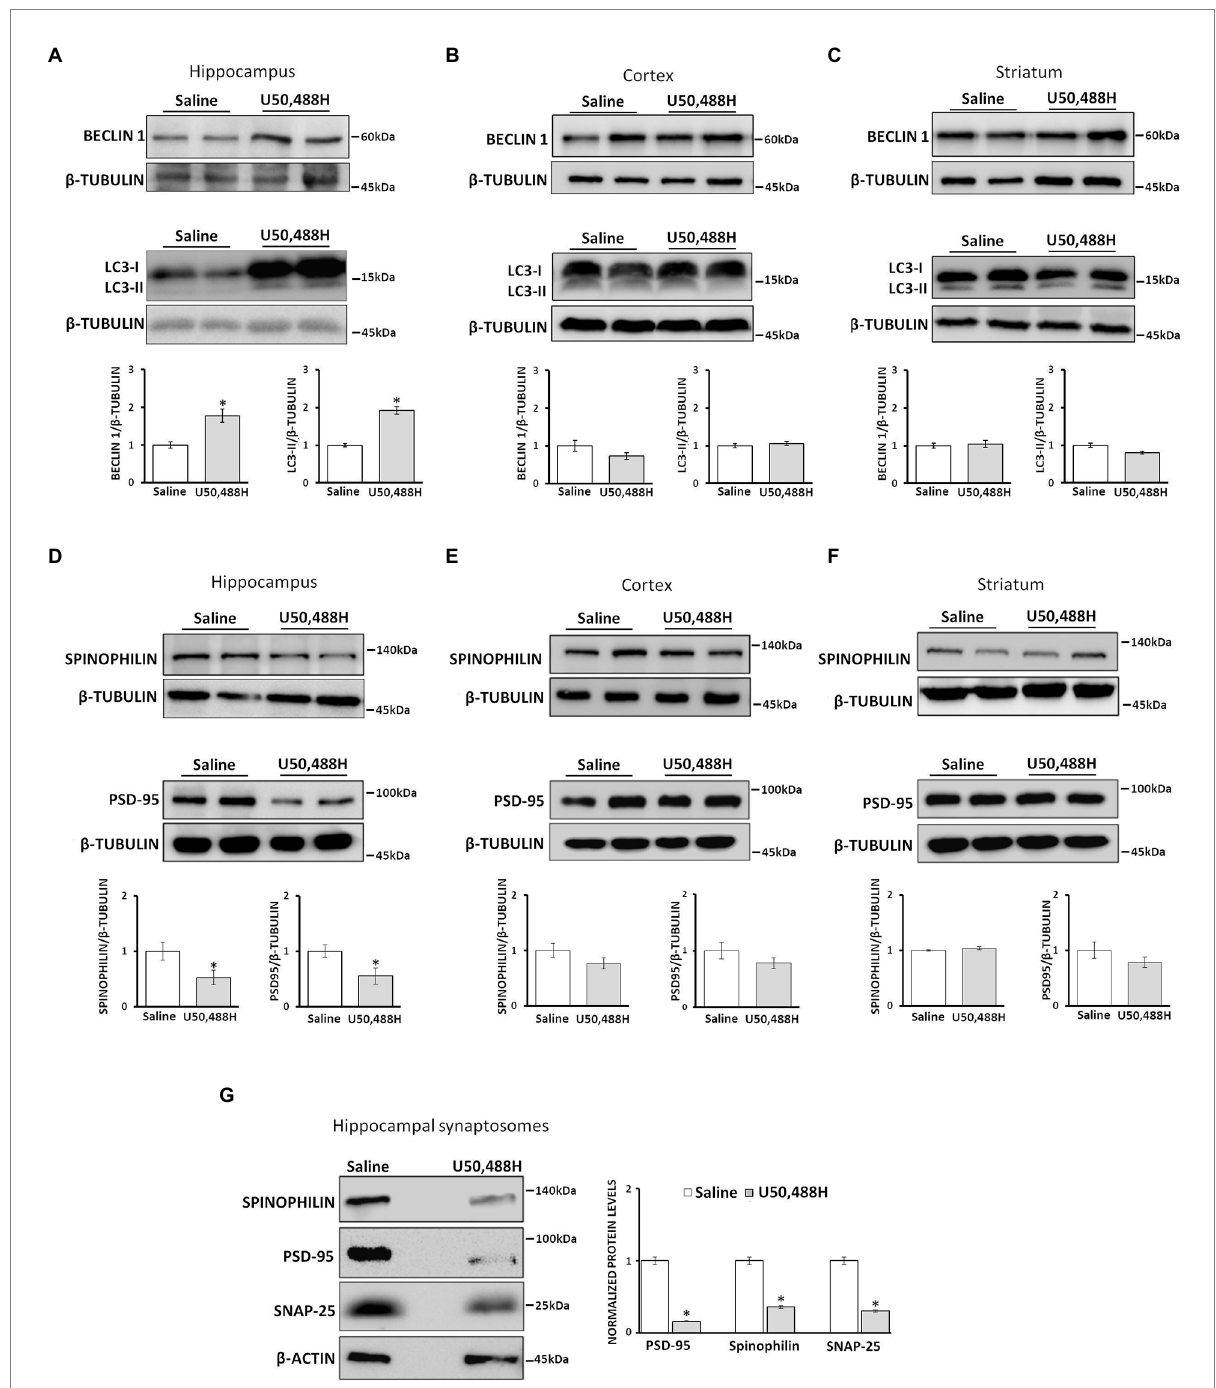
κ - Ο R activation induces autophagy in mouse hippocampus and alters synaptosomal protein levels. Male mice were injected i.p. with saline or 5 mg/kg U50,488H for six consecutive days and the hippocampus (A), cortex (B) , and striatum (C) were isolated and lysed as described in section “Materials and methods.” Autophagosome accumulation was measured by Western blotting using LC3B and Beclin 1 antibodies. Brain lysates from hippocampus (D) , cortex (E) , and striatum (F) of saline-and U50,488H-injected mice were isolated and the protein levels of spinophilin (1:1000) and PSD-95 (1:1000), were measured by immunoblotting using the corresponding antibodies. β -tubulin was used as loading control. (G) Hippocampal synaptosomes of saline-or U50,488H-injected mice were isolated and the levels of spinophilin, PSD-95, and SNAP25 (1:1000) were detected using the corresponding antibodies and quantified by Image J software using β -actin. All data are presented as average ± SEM from three independent experiments ( n = 4/group, * p < 0.05 as compared with saline group using one-way ANOVA with post-hoc